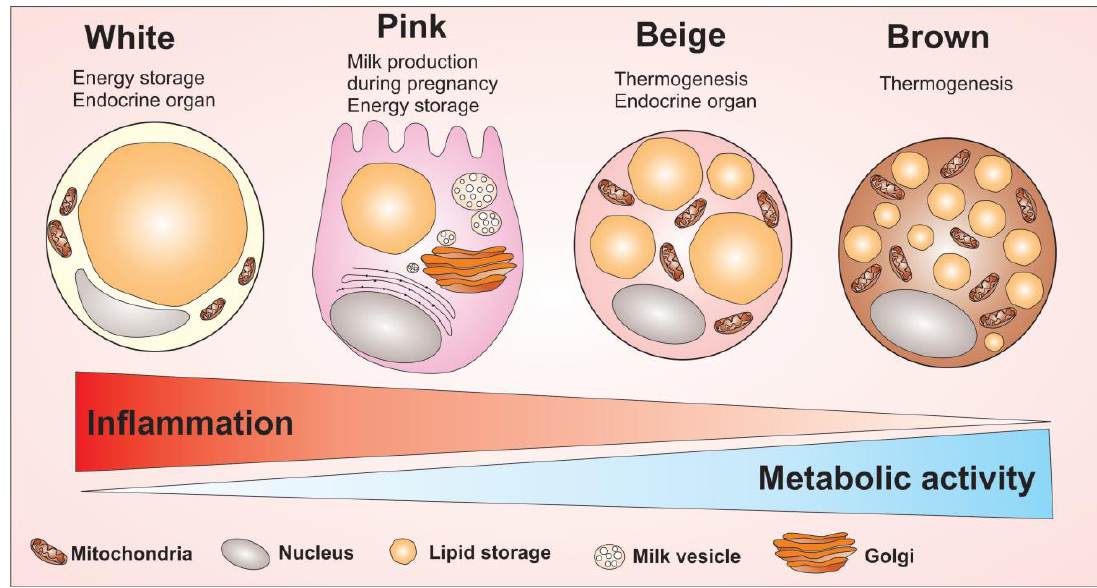
Figure 2. Adipocytes cells and their main morphological and cellular activity differences. Adipocytes are divided into four cell types that have different morphological and functional characteristics: the white, pink, beige and brown adipocytes. The white adipocyte is described as a cell with great energy storage ability, high pro-inflammatory profile, capable of producing several adipokines related to inflammation modulation. The pink adipocyte is described as a cell with a great potential for energy storage as well. However, this cell has a higher metabolic activity compared to white adipocytes, but low ability to regulate inflammation, compared to white adipocytes. Unlike white adipocytes, the brown adipocyte acts to maintain body temperature due to its high amount of mitochondria enriched with UCP1 protein. Brown adipocytes have small fat droplets spread throughout the cell and have a high metabolic activity. Between the two extremes of the white adipocyte to the brown, there is the beige adipocyte. The beige adipocyte has the ability to produce heat due to the high number of mitochondria, with the highest metabolic activity among all four types of adipocytes. Overall, the figure shows the morphological difference between the adipocytes cells as well as indicate the capacity to modulate inflammation and the metabolic activity of adipocytes.